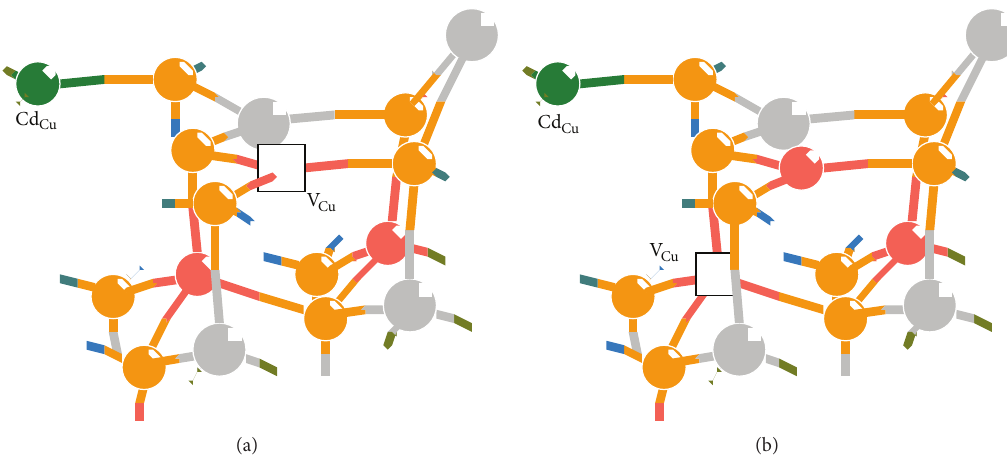
Cu and V Cu at the different layers. The red, gray, and